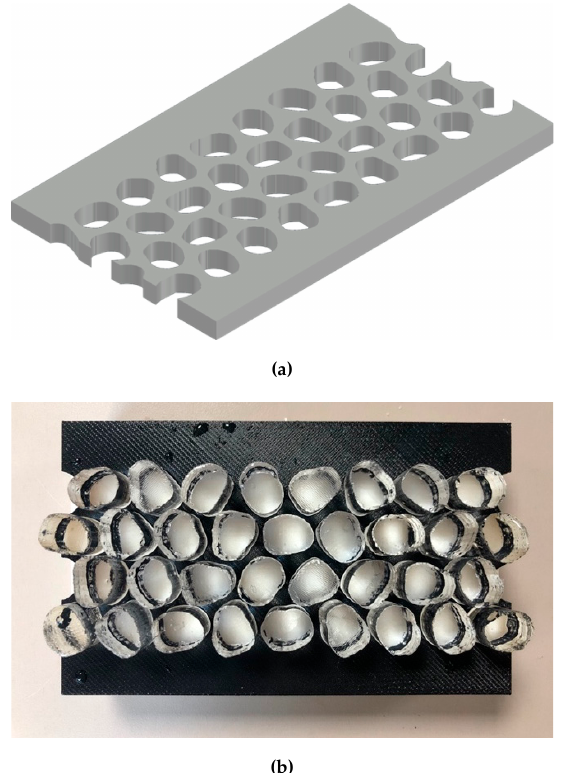
Figure 5. Testing apparatus showing hydrogel particles placed at a fixed porosity and saturating water infused with fluorescent nano particles.